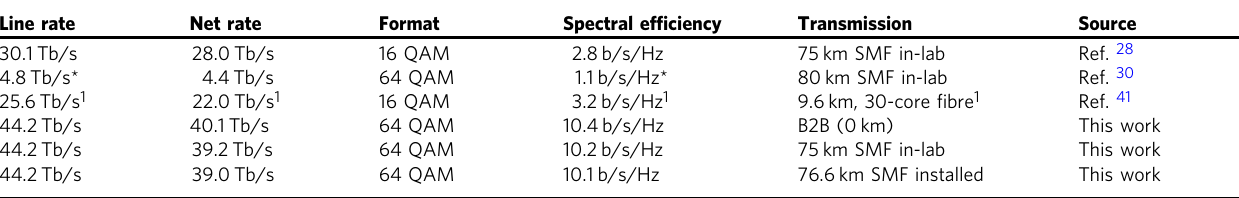
Table 1 Key systems performance